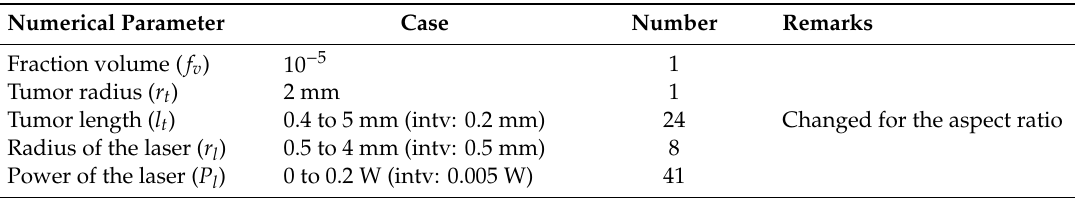
Table 4. Parameters used for numerical